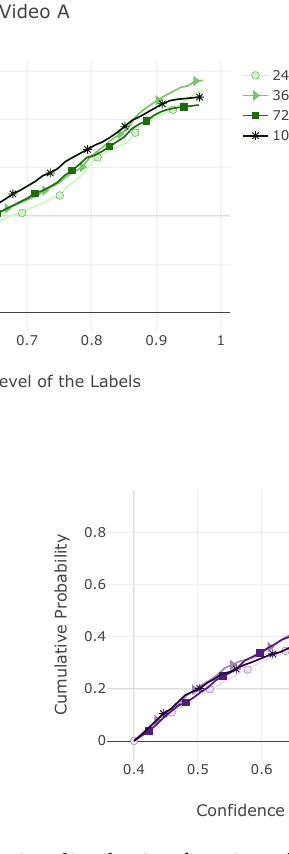
Figure 7. Empirical cumulative distribution function of the confidence level associated with the labels at different video resolutions for CVI in three different videos: A, B and C.